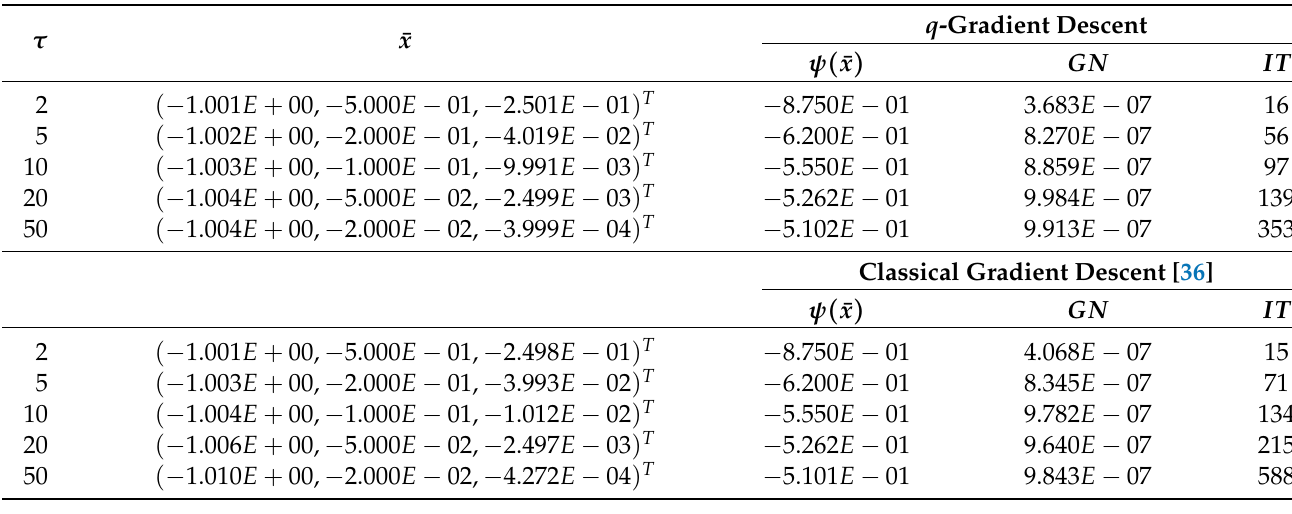
Table 1. Numerical results of Example